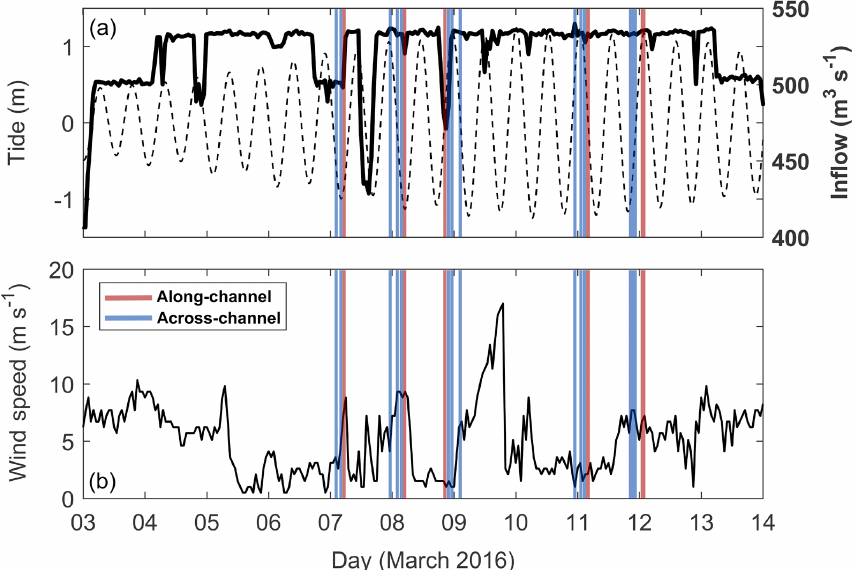
Figure 2. Boundary conditions for the duration of the March 2016 experiment. (a) Discharge from the Manapouri hydroelectric power station (solid) and tides (dashed), and (b) wind speed recorded at the head of Deep Cove. Periods when along-channel (red) and across-channel (blue) transects were sampled are indicated.